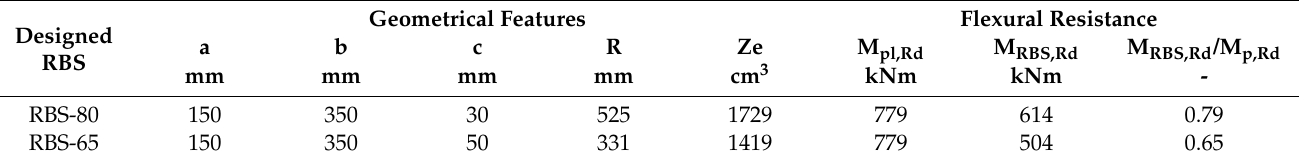
Table 2. Features of the designed RBS.